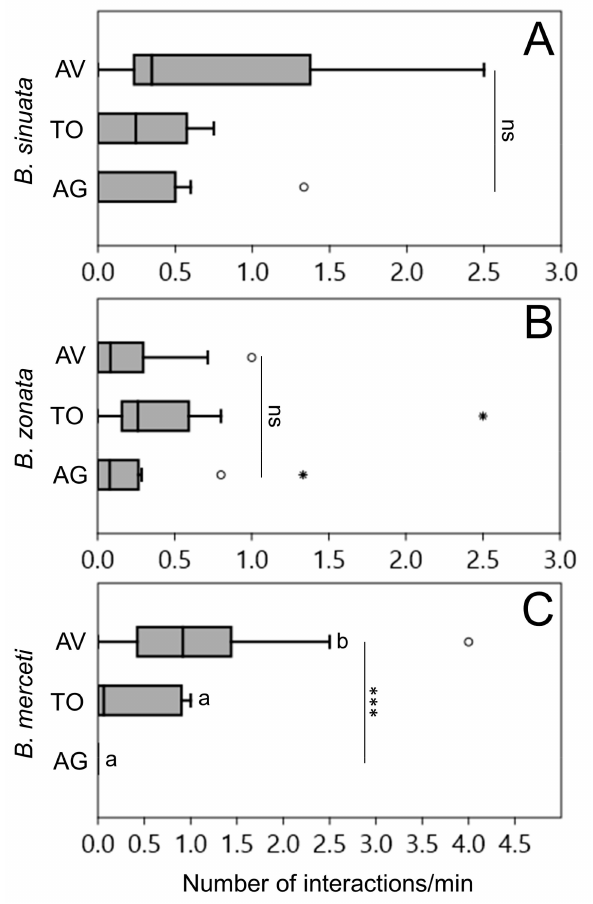
Figure 1. Box-and-whisker plots showing medians (horizontal lines within boxes), 1 ◦ and 3 ◦ quartile (horizontal lines closing the boxes), and maximum and minimum values (ends of the whiskers) for the number of behavioral interactions / minute recorded in circle-tube experiments between the cuckoo wasp P. grandior and its three hosts B. sinuata ( A ), B. zonata ( B ) and B. merceti ( C ). Outliers with a value more than 1.5 times the interquartile range are shown as circles, values with more than three times the interquartile range are shown as stars. *** means that di ff erences among types of interactions are significant at p < 0.001; letters identify pairwise di ff erences (Dunn’s procedure). AV = avoidance interactions, TO = tolerant interactions, AGG = aggressive